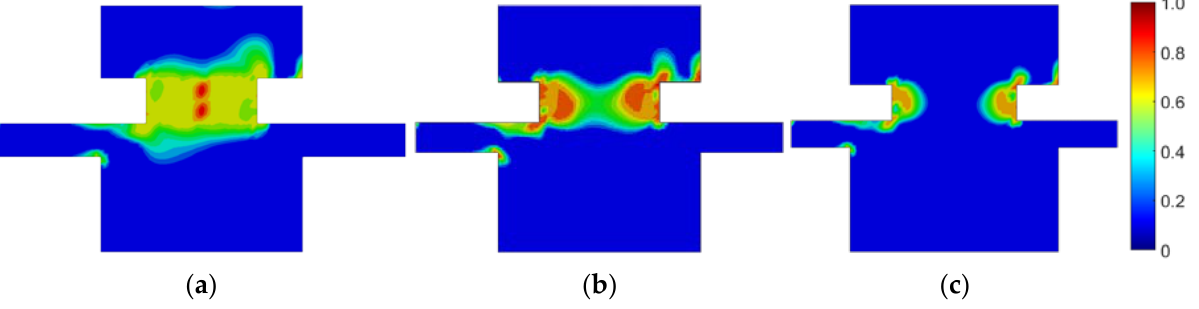
Figure 7. Fatigue distribution of the normalized logarithmic life repeats in the bolt for the model with a prestressed bolt with a nut diameter of: ( a ) 10 mm; ( b ) 12 mm; and ( c ) 14 mm.